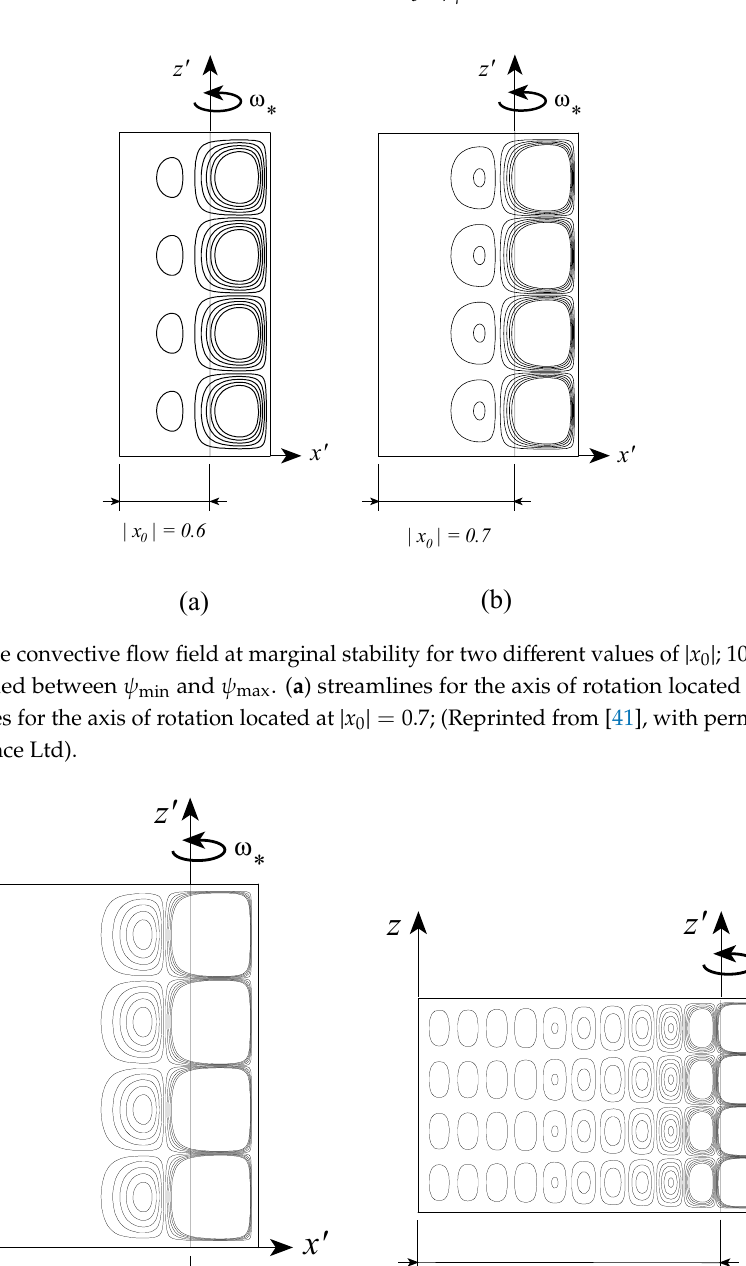
Figure 9. The convective flow field at marginal stability for three different values of x ; 10 0 and ψ . ( a ) streamlines for a layer adjacent to the streamlines equally divided between ψ max min = 0 = 0.3 rotation axis x ; ( b ) streamlines for the axis of rotation located at x ; ( c ) streamlines for 0 0 = 0.5 the axis of rotation located at x ; (Reprinted from [41], with permission from Elsevier Science 0 Ltd.)